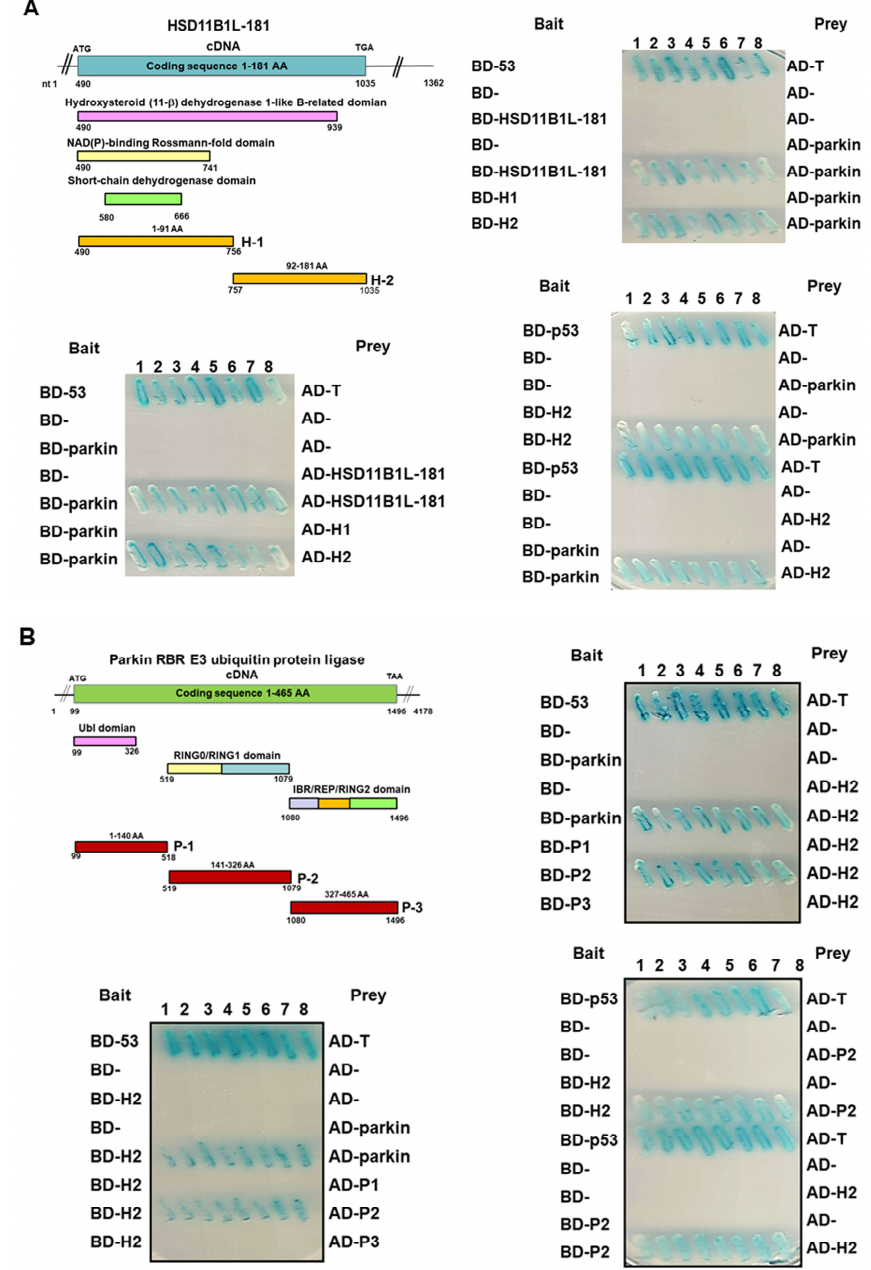
Figure 5. HSD11B1L-181 interacts mainly through the segment of C-terminal and the middle region of parkin using an assay of yeast two-hybrid. ( A ) Schematic representation of the two HSD11B1L-181 deletion mutants used in this assay (top left). One is the amino acid sequence 1–91 (H1 fragment) and the other is the amino acid sequence 92–181 (H2 fragment). The results showed that only the H2 fragment specifically interacted with parkin. ( B ) Schematic representation of the three parkin deletion mutants used in this assay (top left). One is the amino acid sequence 1–140 (P1 fragment), the second is the amino acid sequence 141–326 (P2 fragment) and the last is the amino acid sequence 327–465 (P3 fragment). The results showed that only the P2 fragment of parkin specifically interacted with the H2 fragment of HSD11B1L-181 (top right, bottom left and bottom right). Diploid cells expressing BD-p53 and AD-T were used as positive